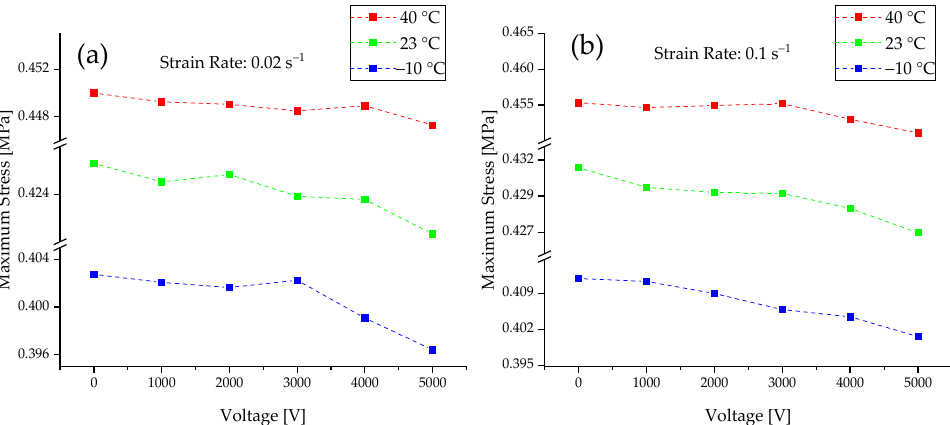
Figure 8. Voltage and temperature dependencies of the maximum stress values during the hysteresis for ( a ) strain rate 0.02 s − 1 and ( b ) 0.1 s − 1.